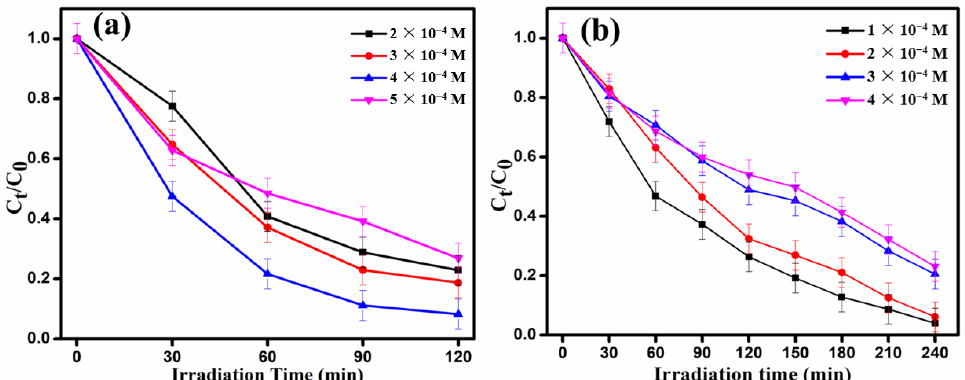
Figure 8. Effect of initial concentration of ( a ) NP and ( b ) BPA pollutant solution on the photodegra- dation efficiency over CLMO surface (20 mg/100 mL) at pH 7.